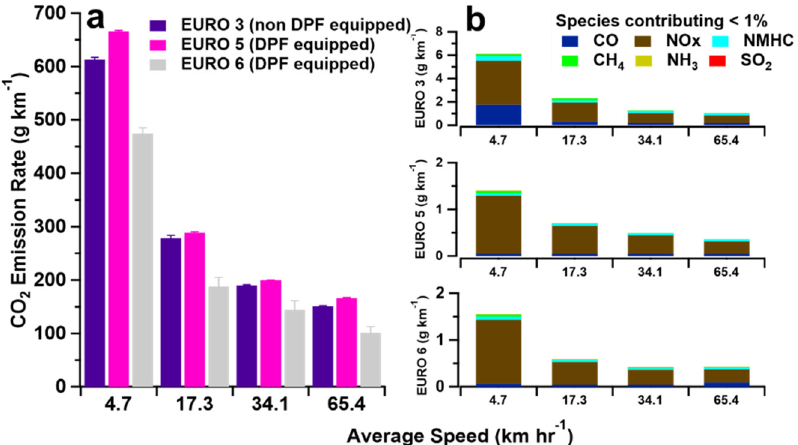
Figure 6. Results obtained from chassis-dynamometer tests performed on diesel vehicles complying with different emission-regulation standards and operating at different speeds. ( a ) Trends concerning CO 2 -emission rates; ( b ) Trends concerning emission rates of CO, NOx, NMHC, CH 4 , NH 3 , and SO 2 gases.